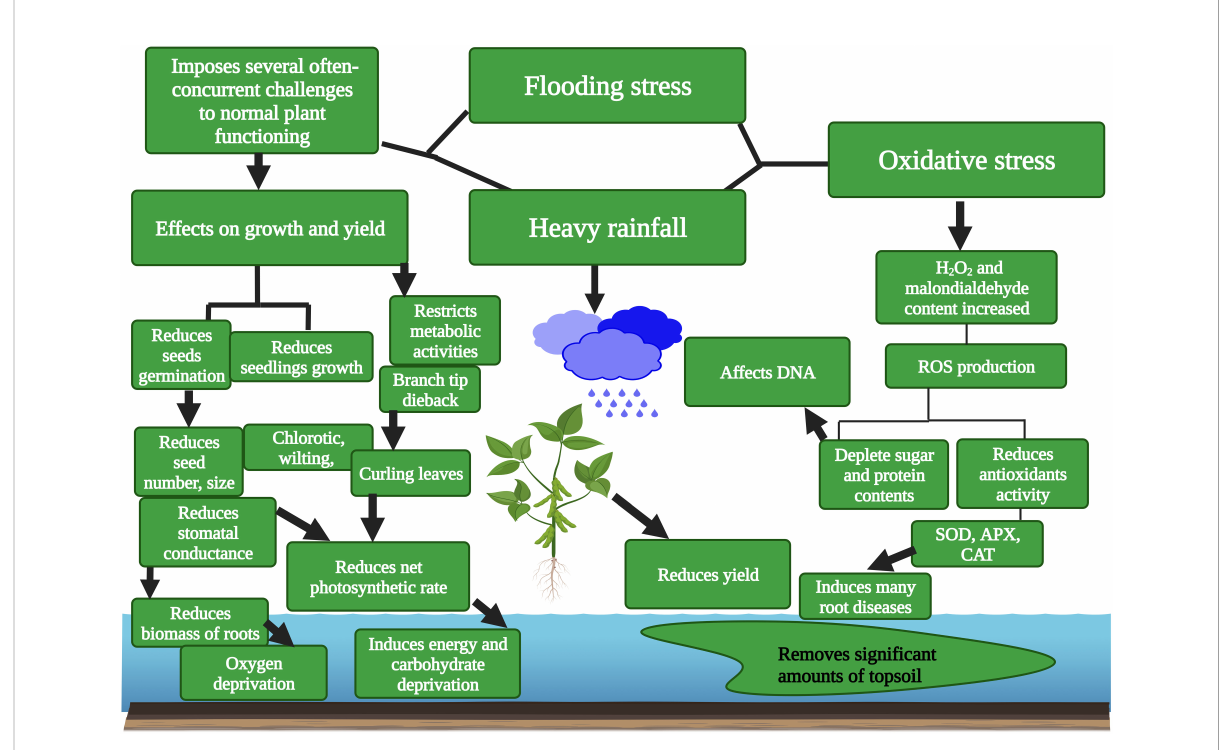
FIGURE 1 Flood stress affects soybean seeds germination, seed size, seed number, seedling growth, stomatal conductance, root biomass, and photosynthesis rate, depletes protein and sugar contents, induces chlorosis and ROS, and reduces antioxidant enzyme activity. This Figure is created with